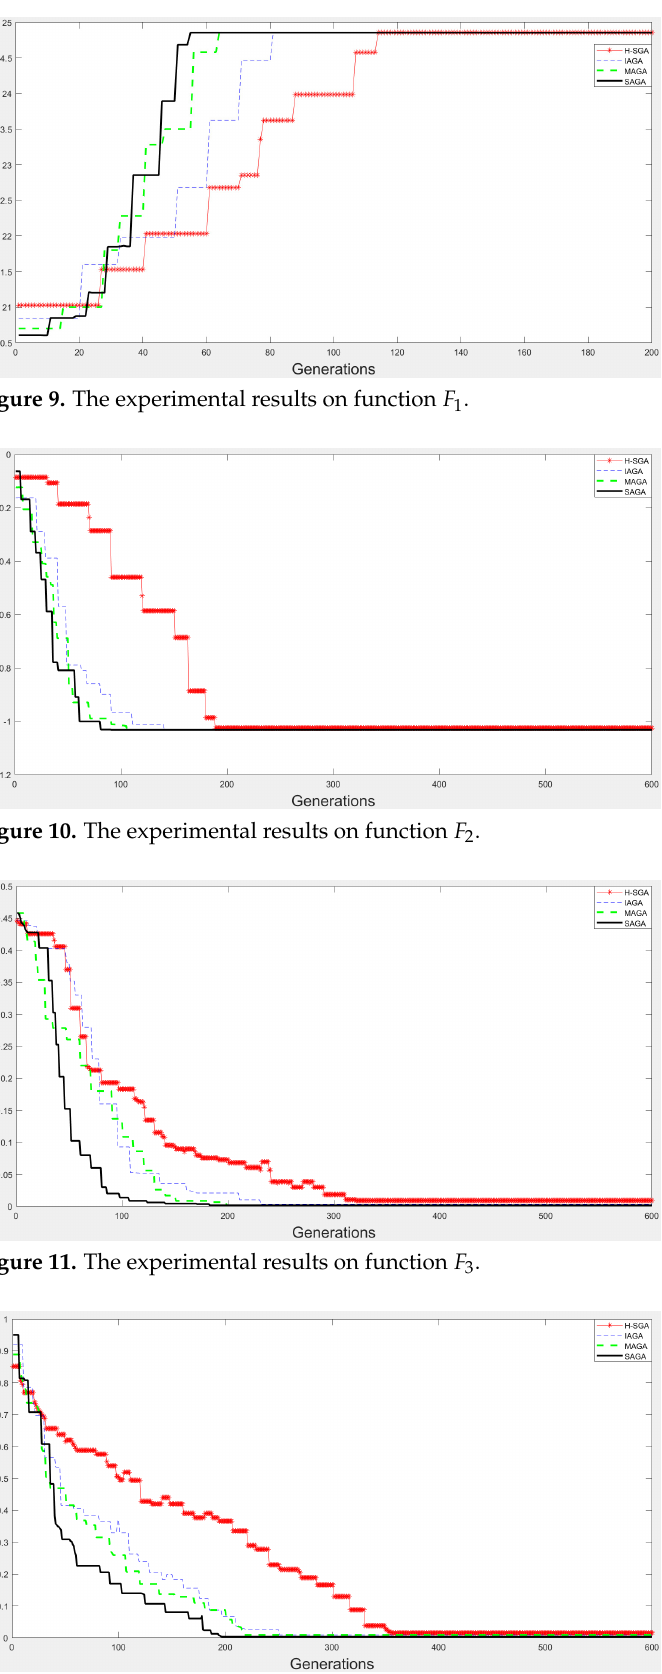
Figure 12. The experimental results on function F 4